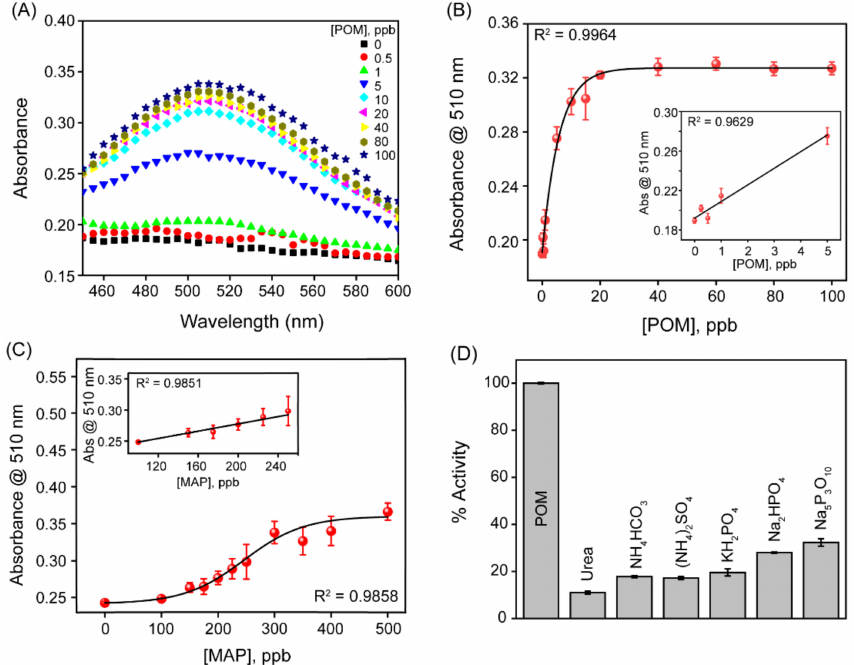
Figure 5. Detection of organophosphorus pesticides. ( A ) UV-Vis absorbance spectra of varying POM concentrations (from 0 to 100 ppb). ( B ) Plot of absorbance values at 510 nm as a function of POM concentration, the black line indicates the dose–response curve fitting while linear fitting in the inset. ( C ) Plot of absorbance values at 510 nm as a function of MAP concentration, the black line indicates the dose–response curve fitting to guide the eye and the inset shows the linear fitting of data, ( D ) Selectivity of POM detection in comparison to other commonly used fertilizers and phosphorus containing small molecules at 100 ppb.